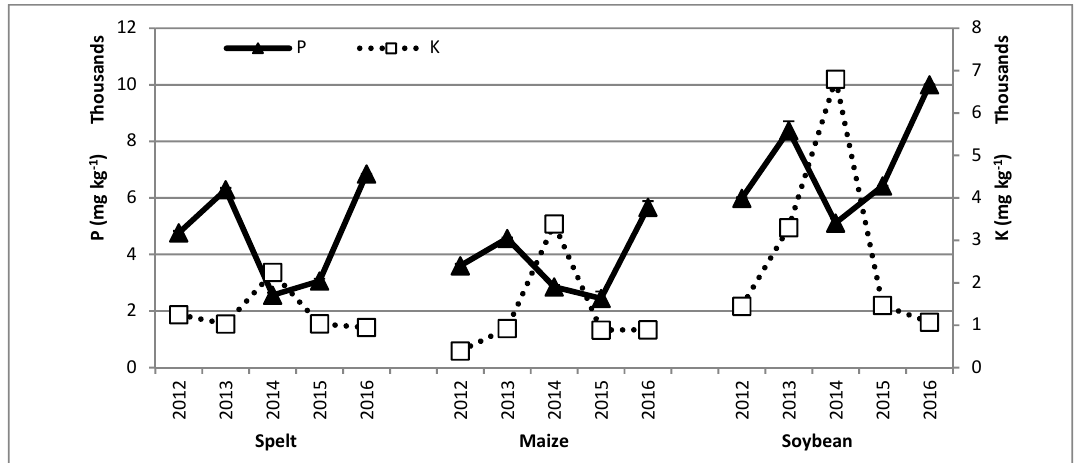
Figure 7. The variation of P and K concentration in grain of organically produced spelt, maize, and soybean (bars represent SD values).